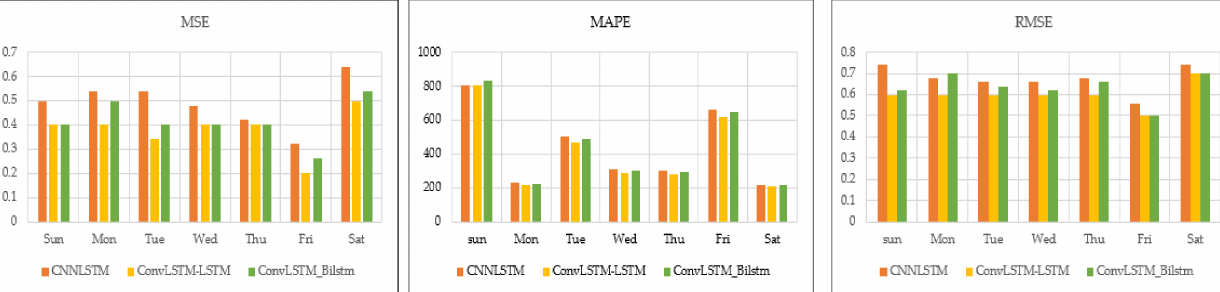
Figure 13. Evaluation metrics for different days in a week with UCI electricity